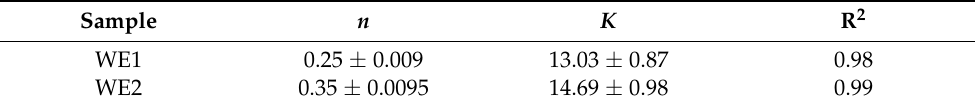
Table 2. Drug release kinetic parameters of electrospun meshes fitted with Korsmeyer-Peppas equation ( K is the release rate constant; n is the release exponent that characterizes the release